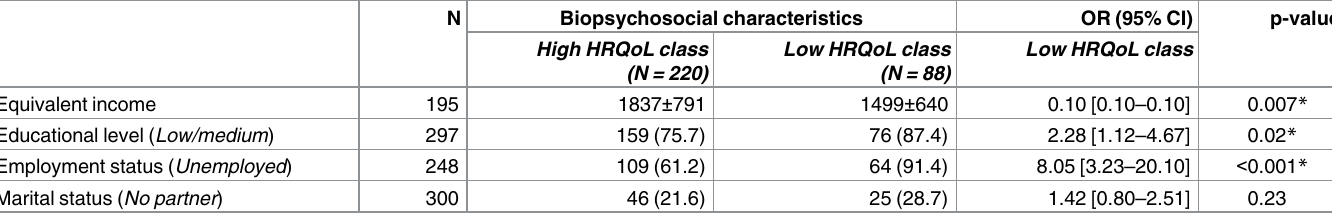
Table 7. Context-related characteristics of T2DM patient across different classesof HRQoL.